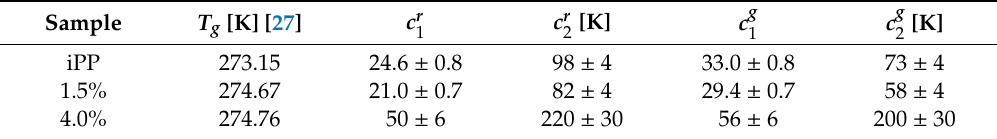
Figure 5. Shift factor, a T , versus absolute temperature for the polypropylene (iPP) matrix and iPP-HrGO with 1.5 and 4 wt.% filler loading. The line is a result of a fit to the WLF equation, Equation (1). Table 1. Summary of WLF equation parameters, Equation (1), from fitting the experimental